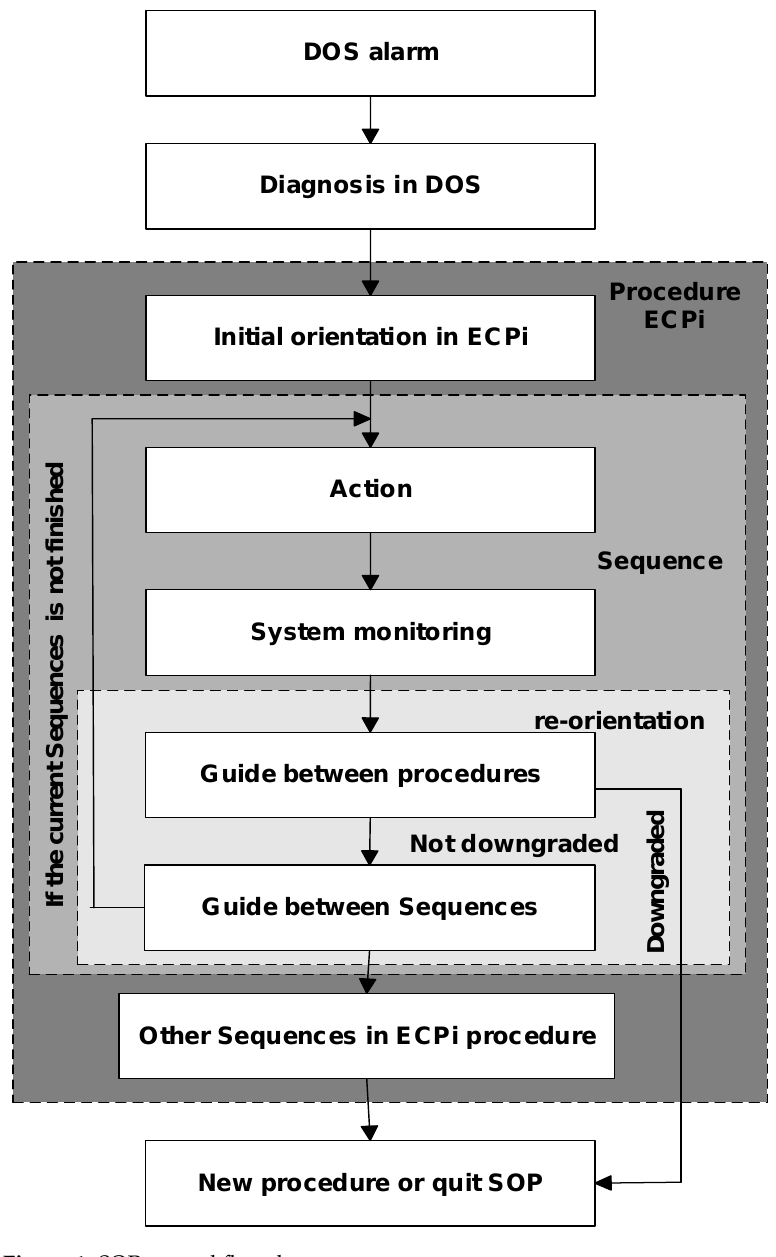
Figure 1. SOP control flowchart.